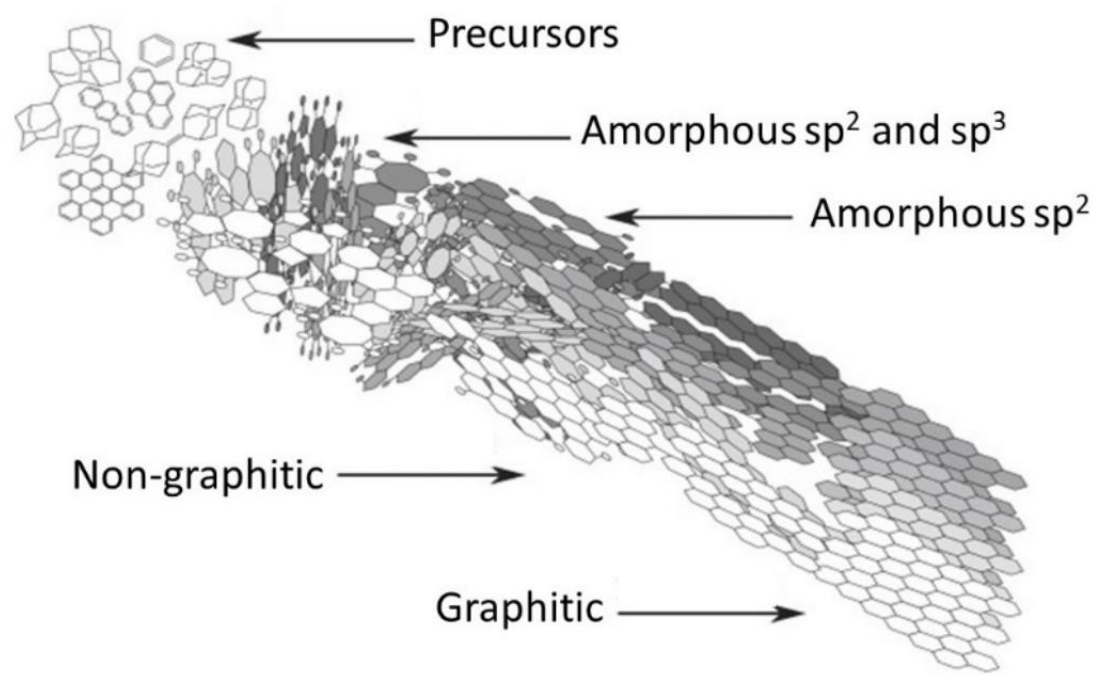
Figure 3. Example of biochar structure intended as a stacked crystalline graphene sheets and randomly ordered amorphous aromatic structures (this figure has been reproduced from Reference [51]).